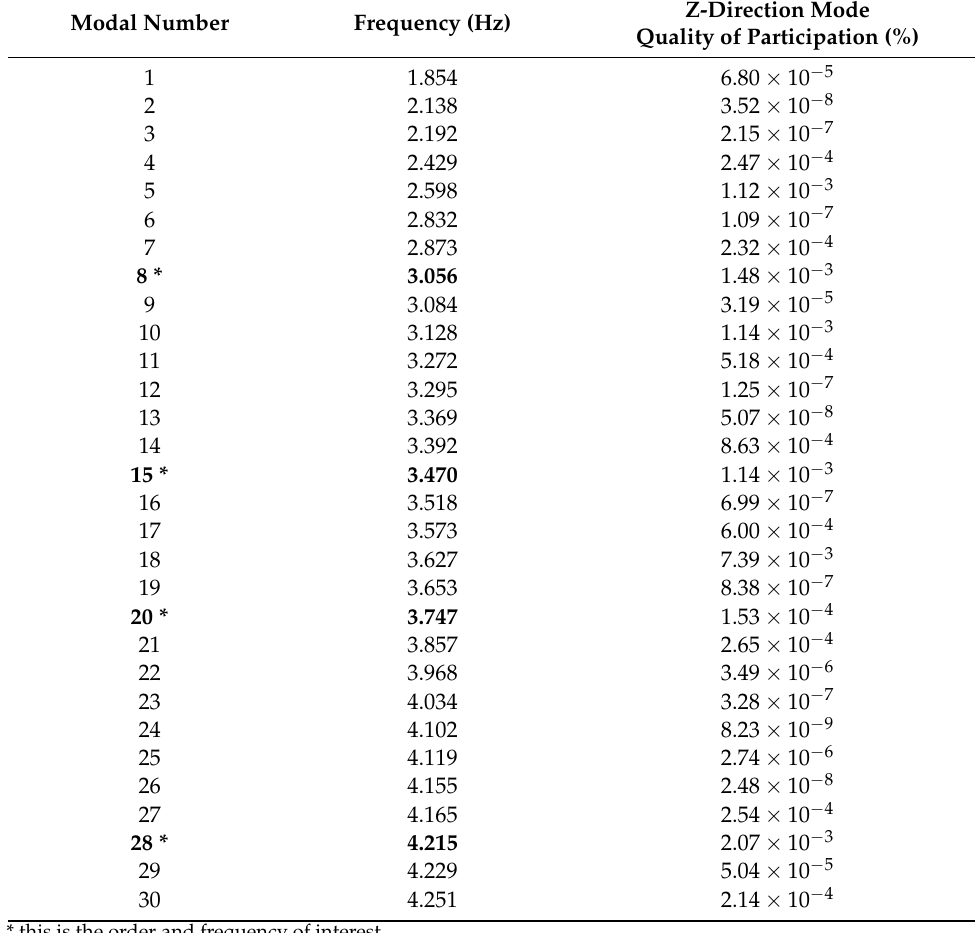
Table 3. First 30 modes and their quality of participation.